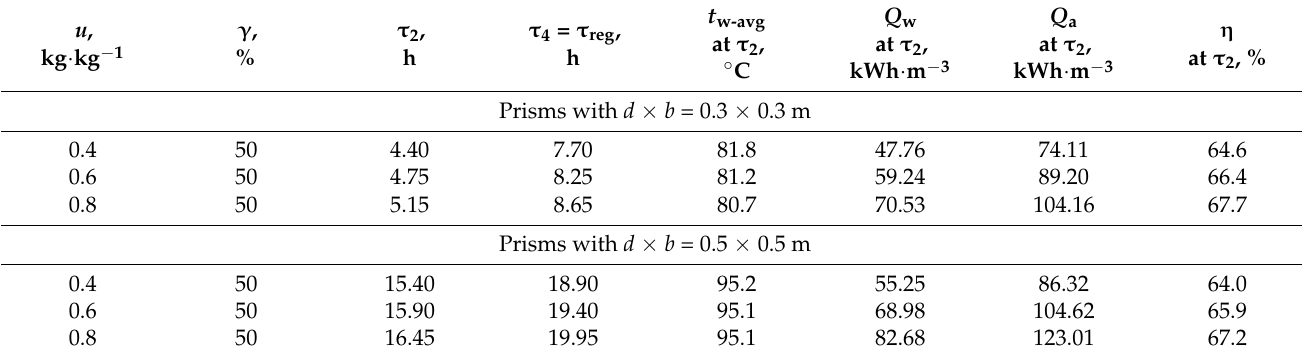
Table 4. Change in the Energy Efficiency η of the Regimes for Autoclave Steaming at t m1 = 130 ◦ C and γ = 50% of